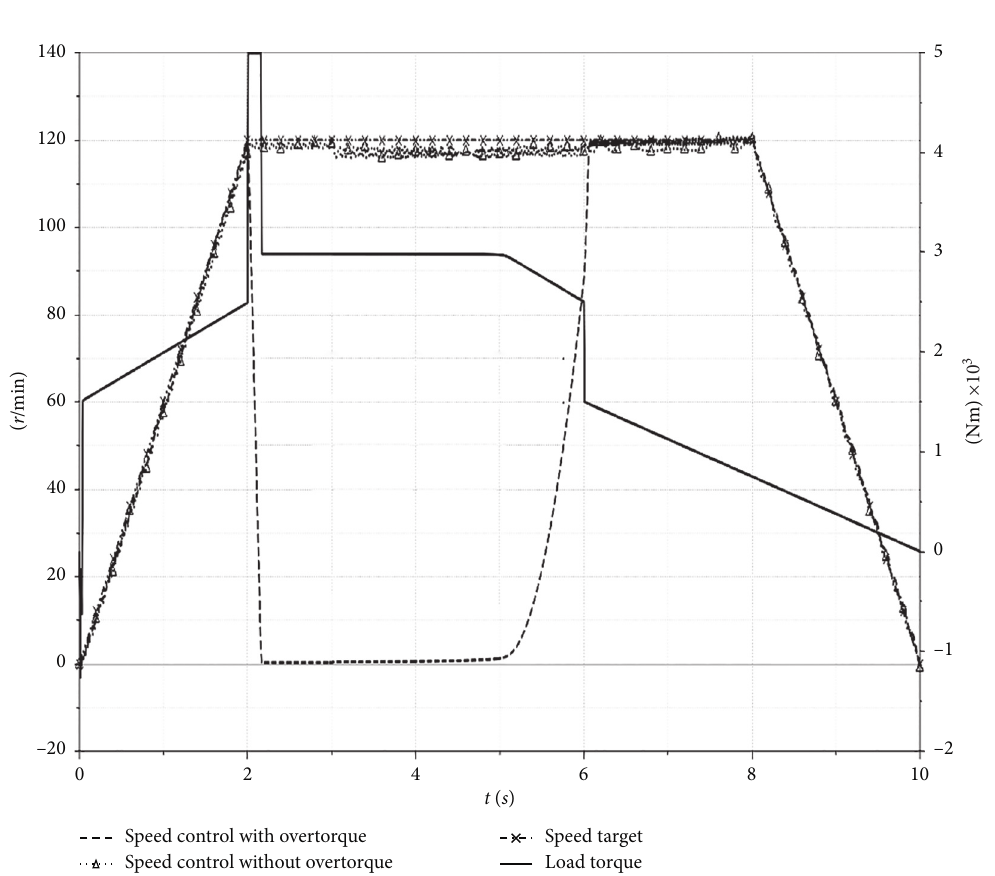
Figure 3: Torque-speed curve of power head output.